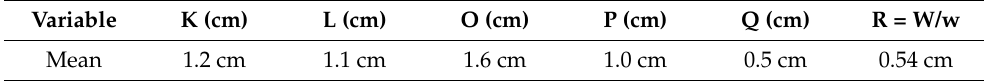
Figure 2. Q, W, and w distances from lateral and transverse views. Table 1 enumerates the mean values of Figures 1 and 2. Table 1. Mean values of anthropometric measurements.